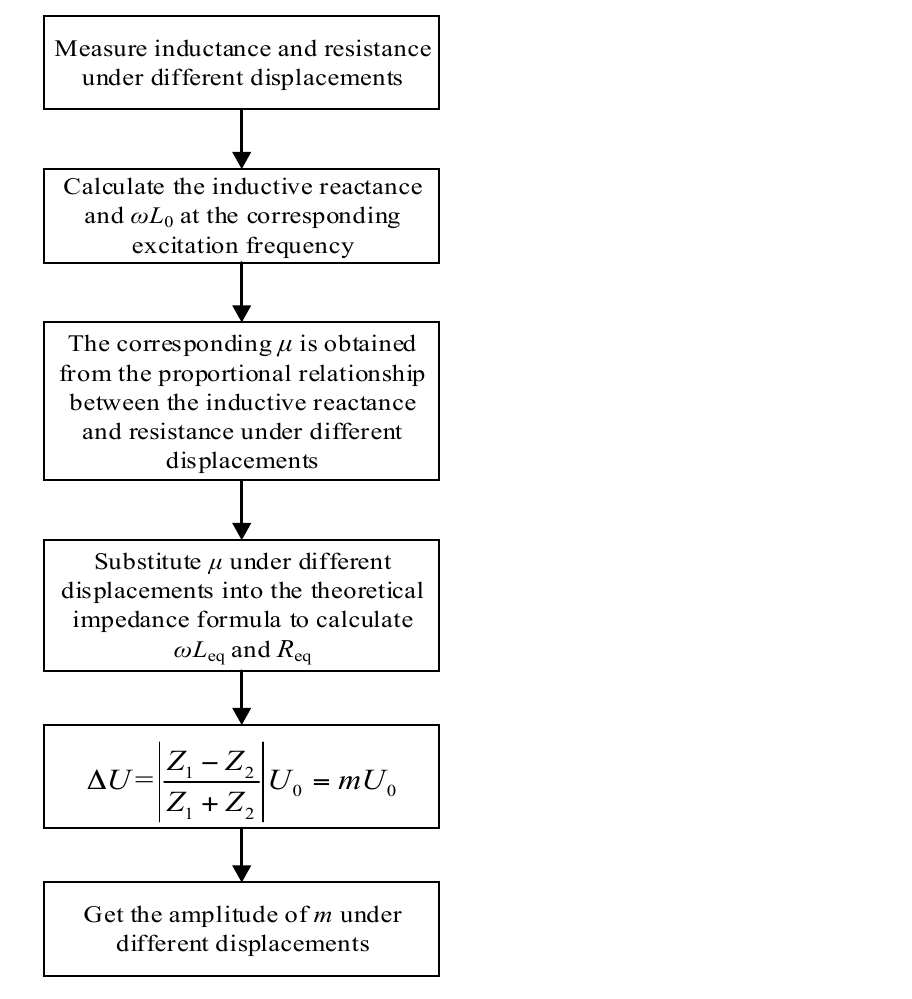
Figure 12. The calculation flow chart of the ratio of output voltage to input voltage under different displacements.